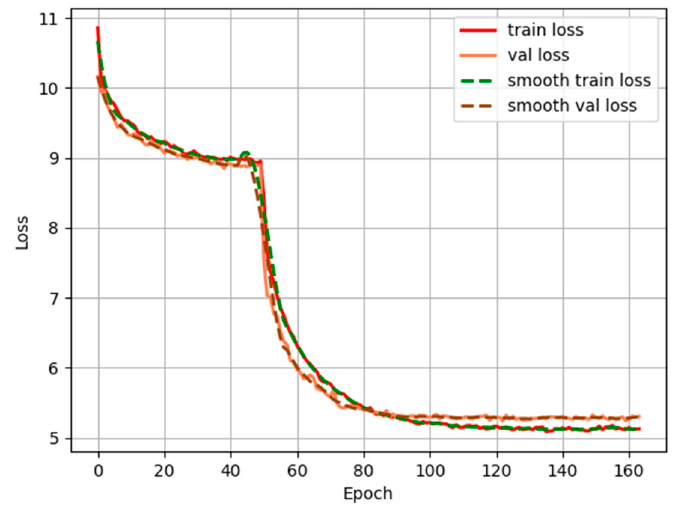
Figure 6. The training curve of the loss